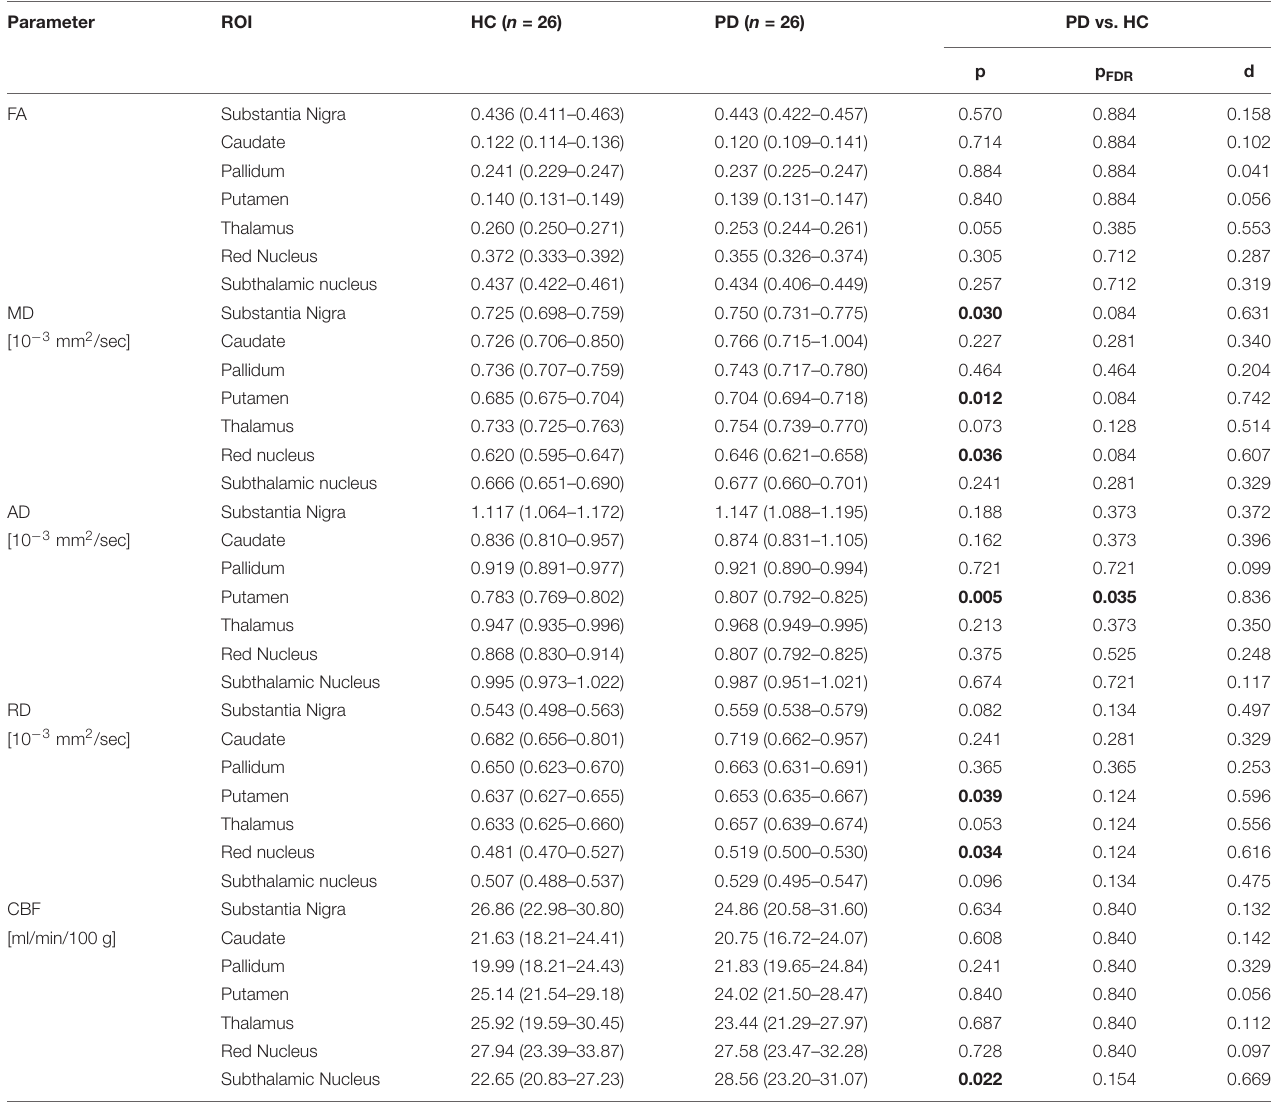
TABLE 2 | Median (IQR) values of FA, MD, AD, RD, and CBF for HC and PD groups within the